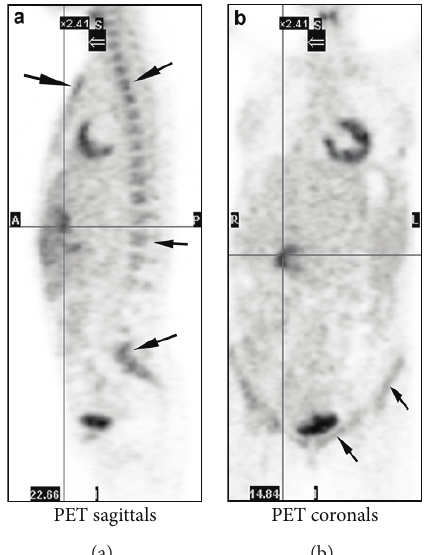
Figure 2: PET-CT (FDG) diffuse increased uptake (arrows) in bone marrow of the sternum and vertebral bodies (a) as well as pelvic bones (b). No pathological uptake in lymph nodes or